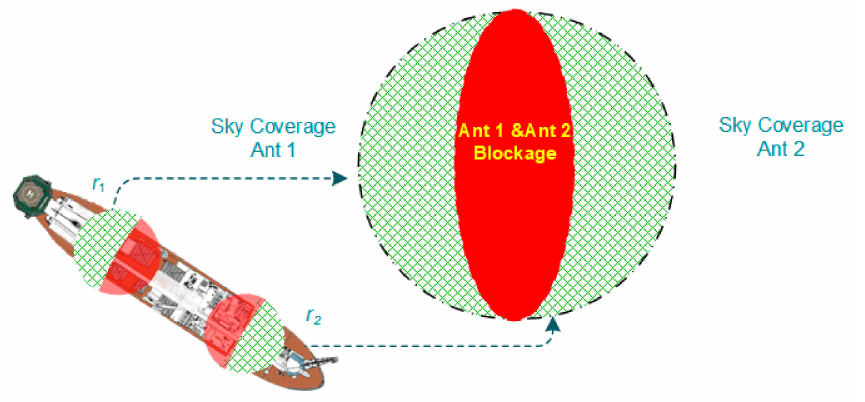
Figure 1. Schematic scenario of two rover-receivers equipped platform, Ant 1 and Ant 2 denote antennas for rover receivers r 1 and r 2 ,